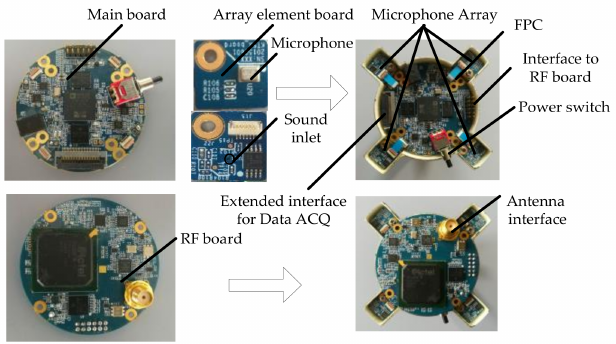
Figure 10. Photograph of the micro-electro-mechanical system (MEMS) microphone array system, array aperture is 68